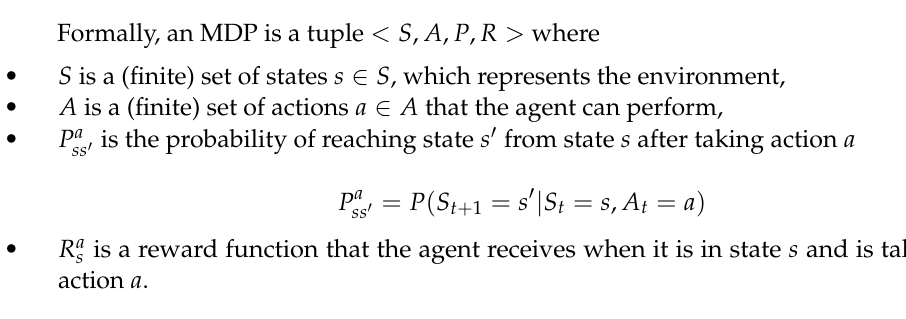
Figure 1. Reinforcement Problem–Interaction between agent and its